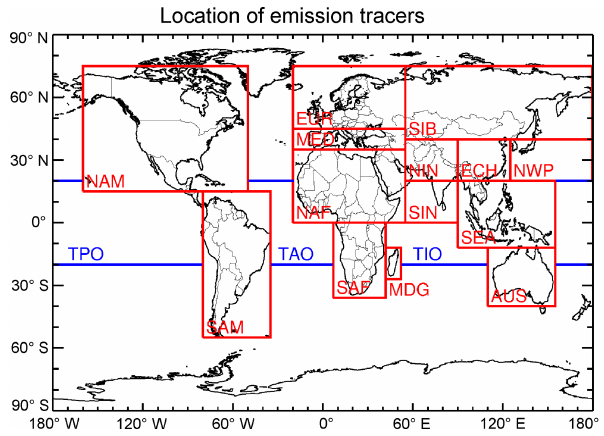
Figure 1. Global geographical location of artificial boundary layer source regions in the CLaMS model, also referred to as “emission tracers”, adapted from Vogel et al. (2015). The latitude and longi- tude range for each emission tracer is listed in Table 1.